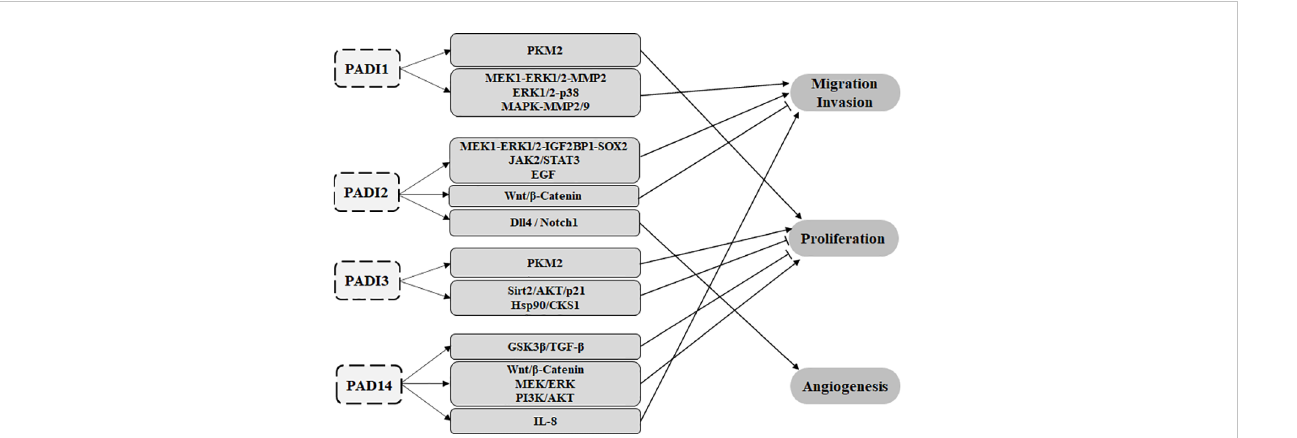
FIGURE 4 The PADI family can participate in tumour proliferation, migration, invasion and angiogenesis through various signalling pathways. PADI1 and PADI3 can promote glycolysis through the citrullination of PKM2, leading to the proliferation of tumour cells. PADI1 can promote tumour migration and invasion through MEK1-ERK1/2-MMP2, ERK1/2-p38 and MAPK-MMP2/9. PADI2 can promote tumour migration through the MEK1-ERK1/2-IGF2BP1- SOX2, JAK2/STAT3 and EGF signalling pathways. PADI2 also affects Wnt/ b -catenin to inhibit tumour metastasis. PADI2 can promote tumour angiogenesis through the Dll4/Notch1 signalling pathway. PADI3 can inhibit tumour proliferation through Sirt2/AKT/p21 and Hsp90/CKS1. PADI4 can act on IL-8 to promote tumour cell metastasis. PADI2 can also affect Wnt/ b -Catenin, MEK/ERK and PI3K/AKT to promote the proliferation of tumour cells. PADI4 can also inhibit the proliferation of tumour cells through GSK3 b /TGF- b . At present, there is no report on PADI6 and